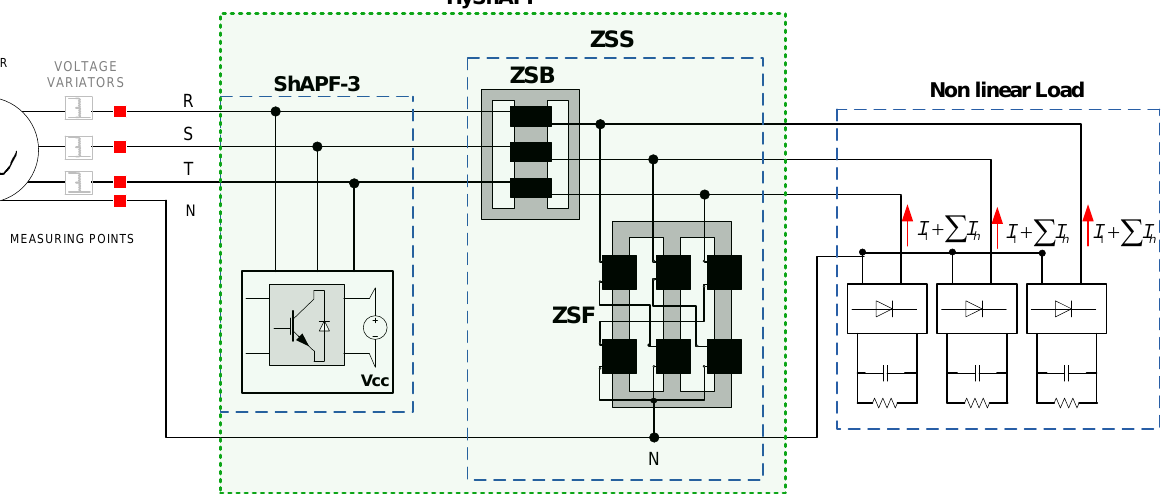
Figure 22. Schematic diagram for experimental studies of the proposed HyShAPF arrangement.